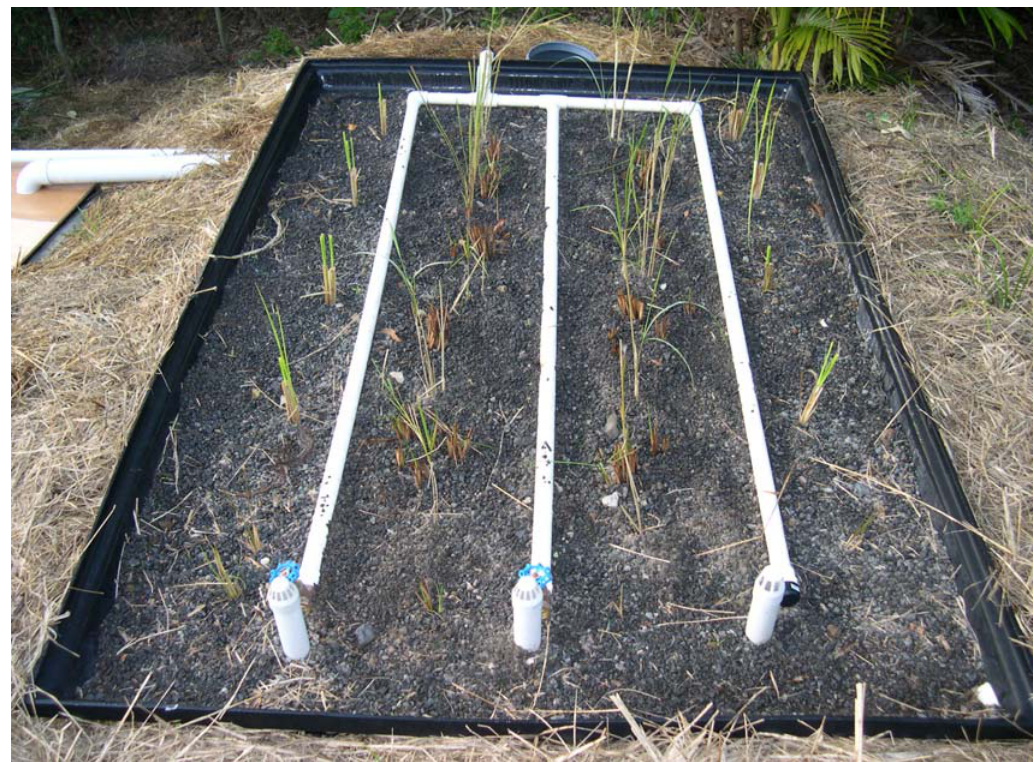
Figure 9. Wastewater distribution at vertical flow (VF) CWs at Bexhill, NSW, Australia. Photograph taken by the